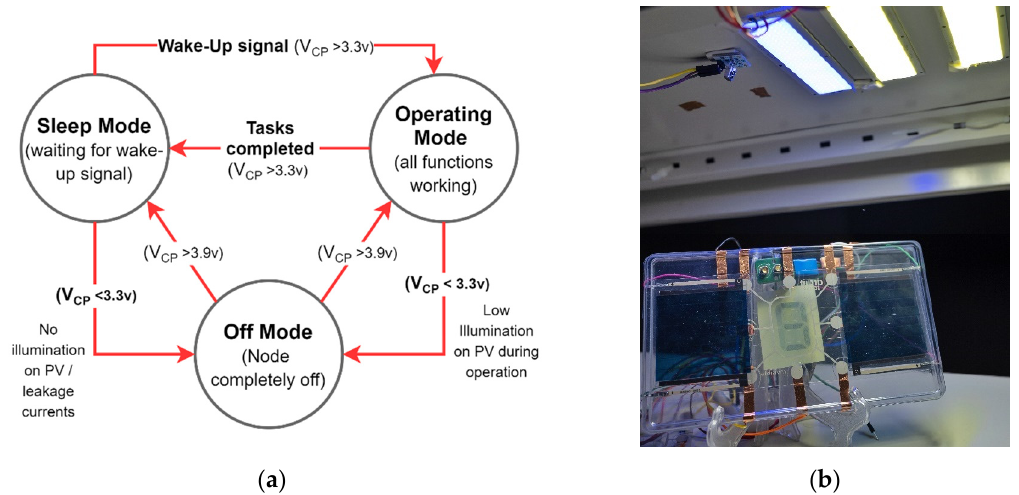
Figure 11. ( a ) State transition diagram and conditional parameters; ( b ) LIoT product label prototype using printed com- ponents.